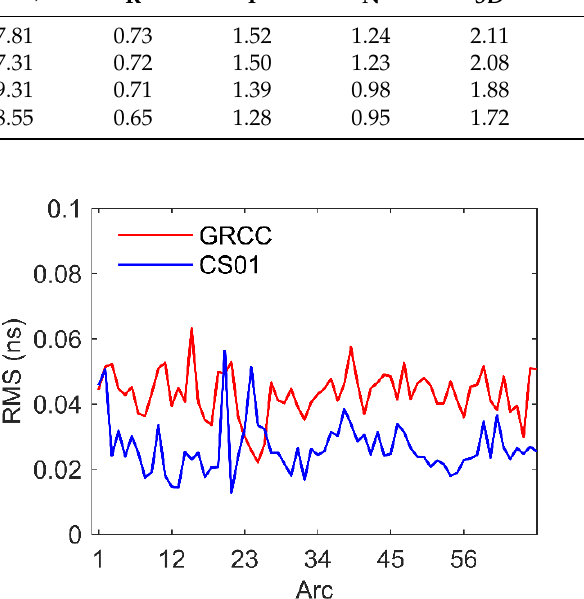
Figure 12. The difference in clock offset between solutions with and without PCV corrections.